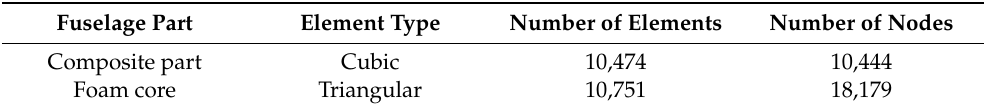
Figure 10. ( a ) Core mesh size, ( b ) Skin mesh size. Table 4. Meshing properties of the simulation model.